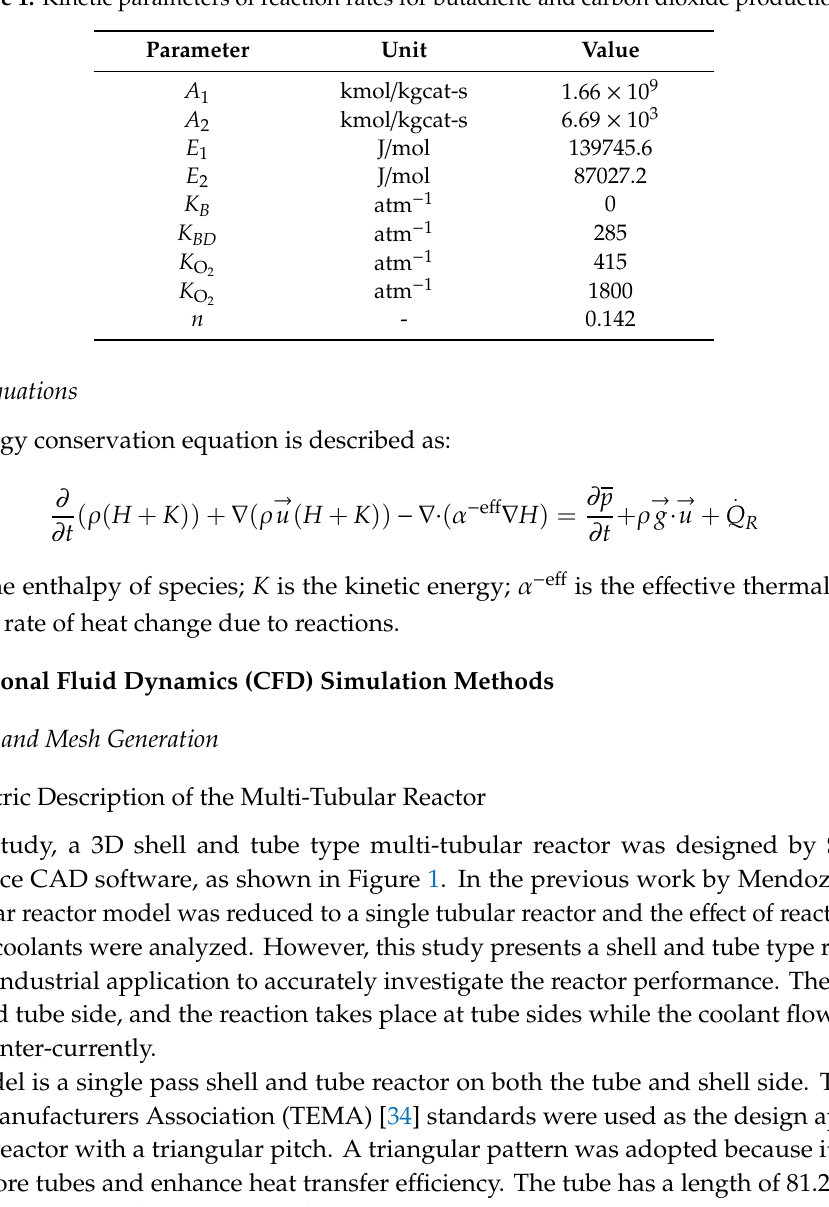
Table 1. Kinetic parameters of reaction rates for butadiene and carbon dioxide